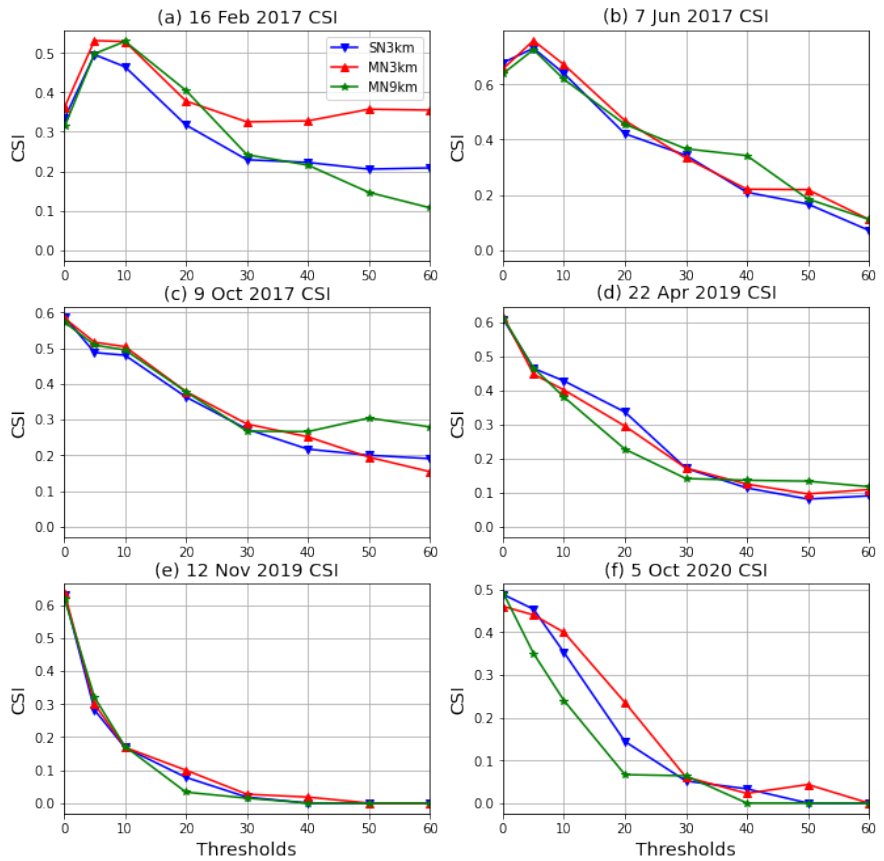
Figure 12. The Critical Success Index for the three configurations and for all six events in the following order ( a ) tropical cyclone Dineo, ( b ) the Cape storm, ( c ) the KZN 2017 October floods, ( d ) the KZN 2019 April floods, ( e ) the KZN 2019 tornadoes and ( f ) the Johannesburg